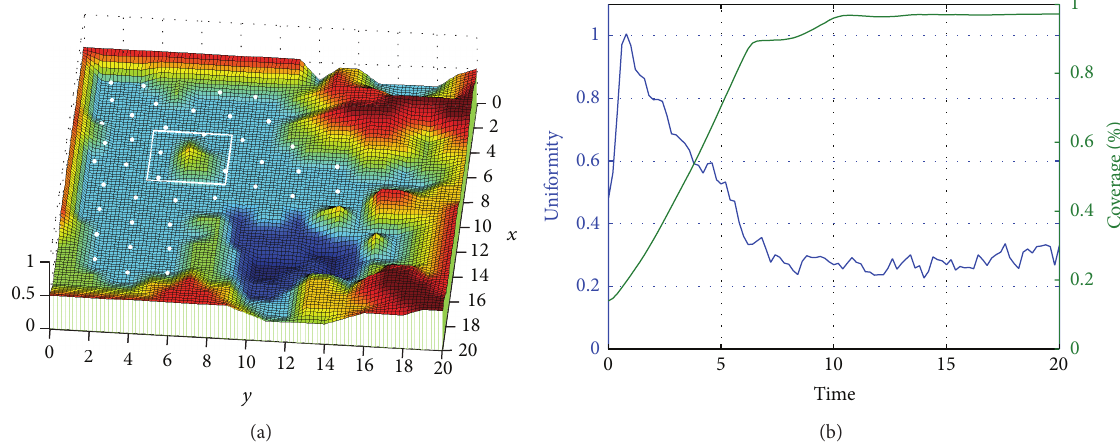
Figure 4: (a) Node position after deployment and (b) network coverage rate and uniformity Curve.